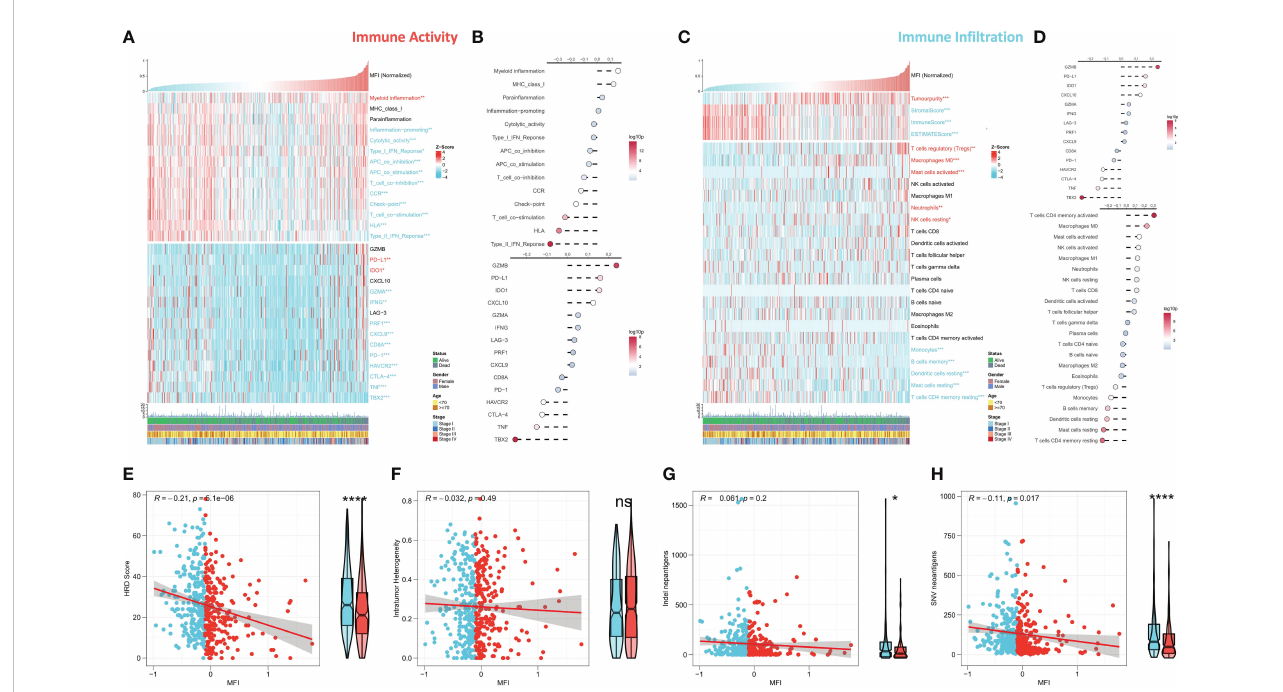
FIGURE 7 Differences in immune in fi ltration between the two subtypes. (A, B) Assessing the relationship between MF, MFI, immune pathway activity, typical immune checkpoints and clinical features in terms of immune activity. Tumor myeloid immunity, PD-L1 and IDO1 were signi fi cantly increased in the high MFI group and positively correlated with MFI. On the contrary, the activity of all immune pathways except MHC Class 1 and paracancerous immunity was signi fi cantly increased in the low MFI group, and almost all immune checkpoints were negatively correlated with MFI and increased in the low MFI group. (C, D) The relationship between MFI, MFI, Estimate score, immune cell abundance and clinical features was evaluated from the perspective of immune in fi ltration. The results revealed increased tumor purity in the high MFI group, while stromal cells and immune cells increase in the low MFI group. In addition, Tregs, M0 macrophages, neutrophils and mast cells increased in the high MFI group, while monocytes, DC cells, memory B cells and CD4 memory T cells increased in the low MFI group. (E – H) Differences between the two groups in four indicators related to tumor-speci fi c antigens: HRD score, Indel neoantigens, Intratumor Heterogeneity and SNV neoantigens. The results showed a signi fi cant negative correlation between MFI and HRD score, Indel neoantigens and SNV neoantigens, and the three indexes were signi fi cantly increased in the low MFI group; however, there was no signi fi cant correlation between MFI and Intratumor Heterogeneity, which indicated more chromosomal instability in the low MFI group and more tumor neoantigens with stronger immune system activity, suggesting that low MFI group tend to bene fi t more from immunotherapy. ns p>0.05; *p< 0.05; ****p<